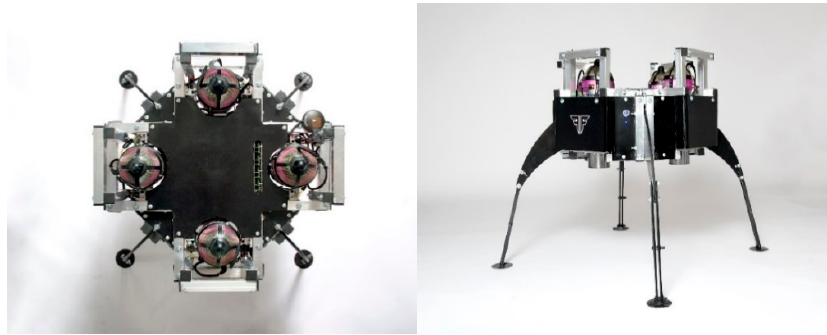
Figure 1. Main structure of a JetQuad (JQ) [13].